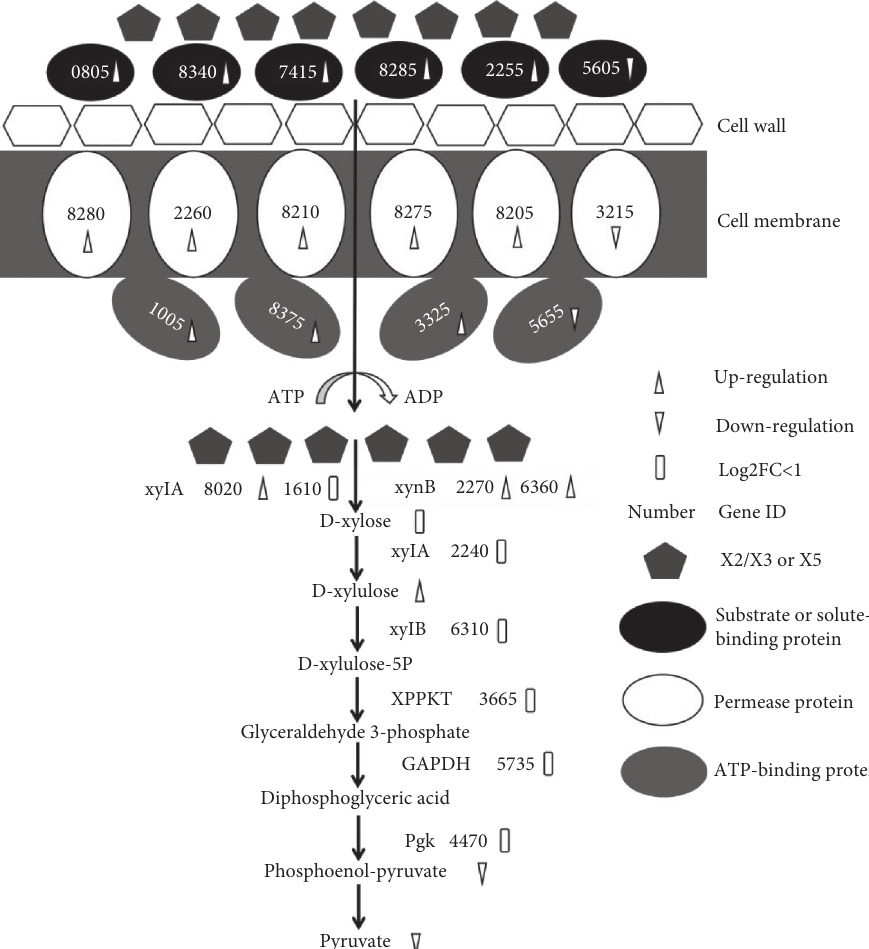
Figure 5: Proposed model for the catabolism of different polymerized XOS in B . adolescents . The numbers indicated the respective genes in the genome of B . adolescents , omitting the